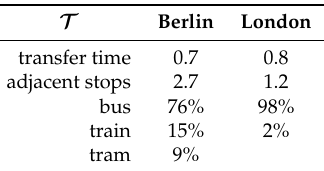
Timetable characteristics: average transfer time (mins), average degree of adjacent stops/stations, and percentage of transportation means (% of